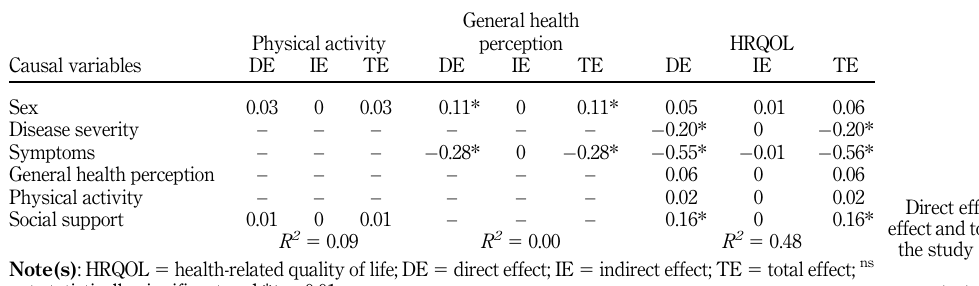
Table 3. Direct effect,